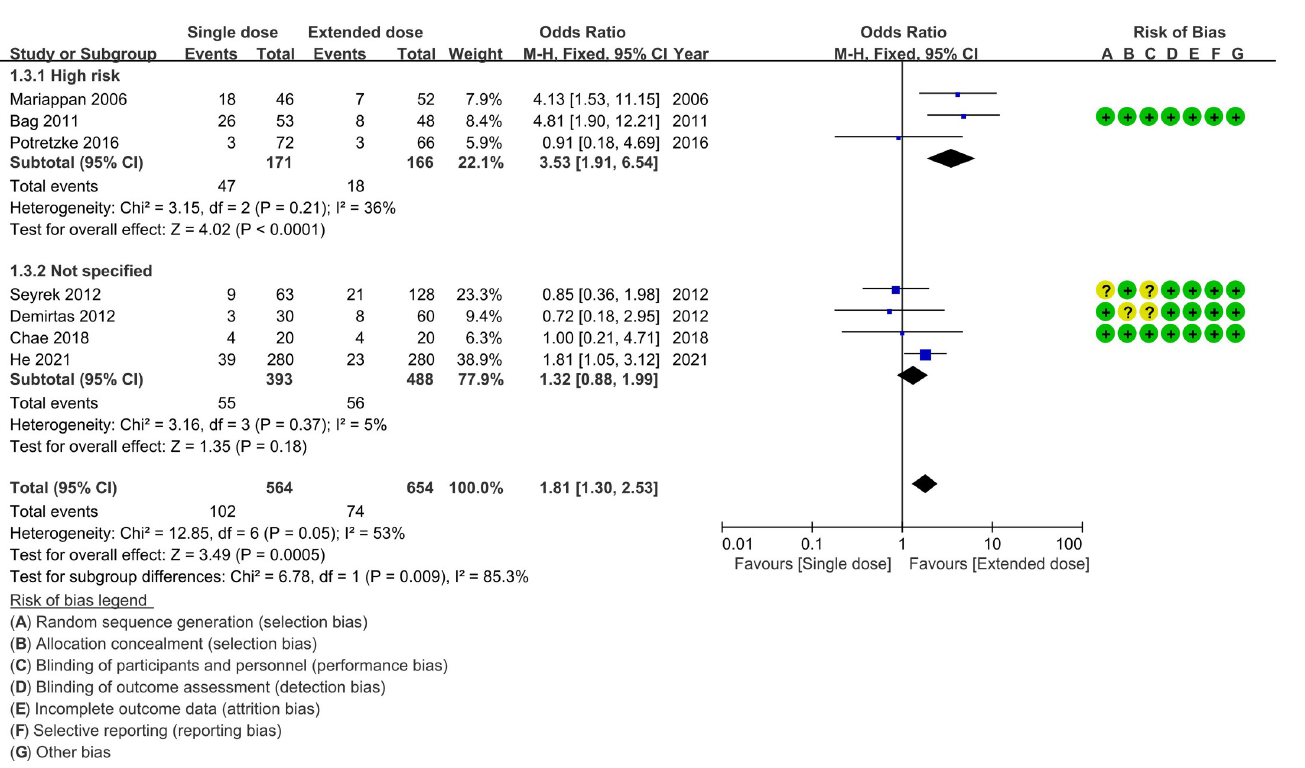
Fig 4. Forest plot. Single dose vs. extended dose in patients with